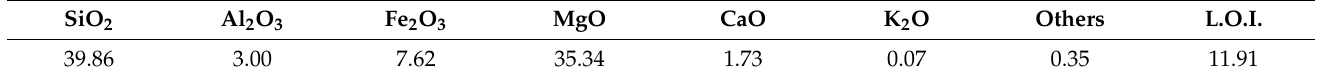
Table 1. XRF ore results (%) (L.O.I. = lost on ignition).